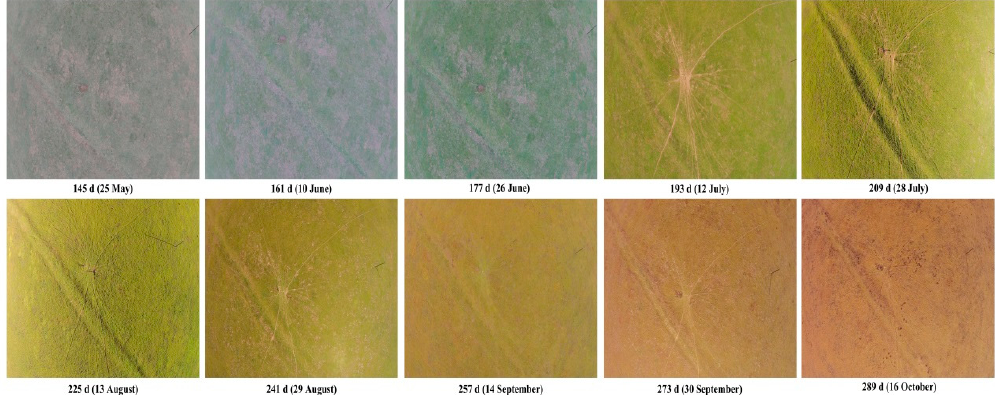
Figure 2. Digital photograph acquired by an unmanned aerial vehicle for one of quadrat of plot 7 in the permanent sample plot area in the growth season of 2015.